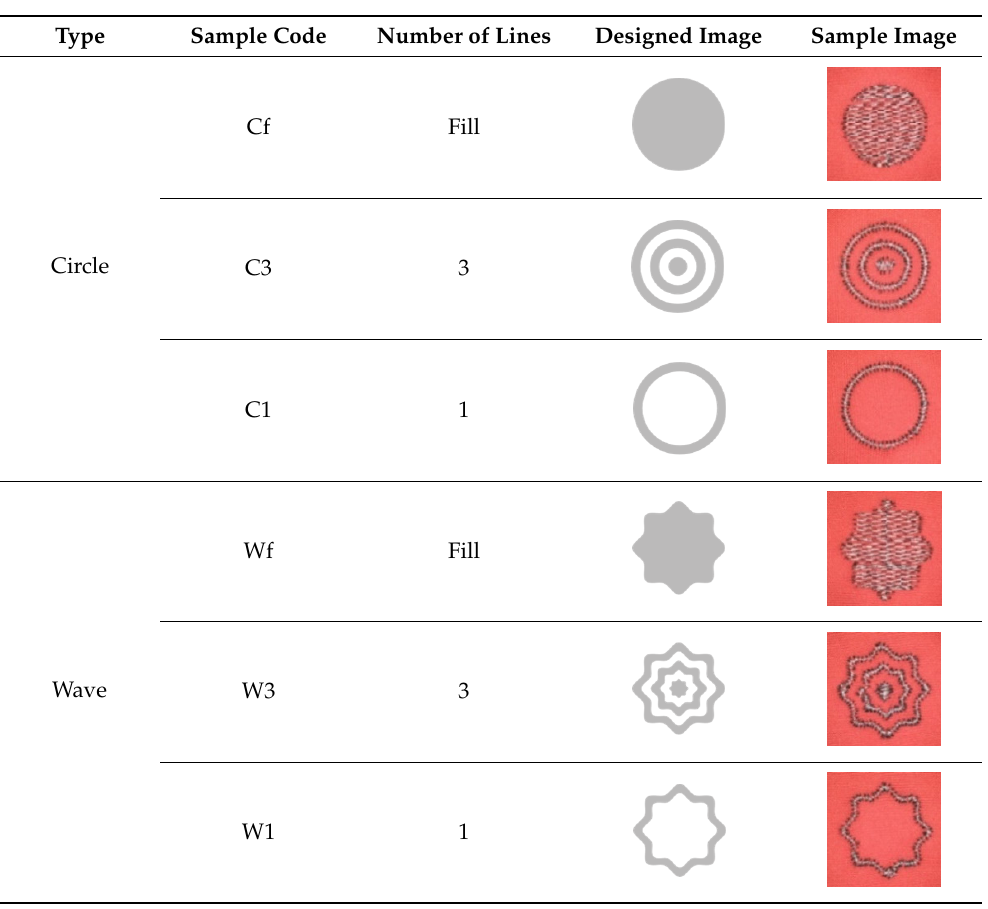
Table 1. Sample code and images of the embroidery electrode used in this study.